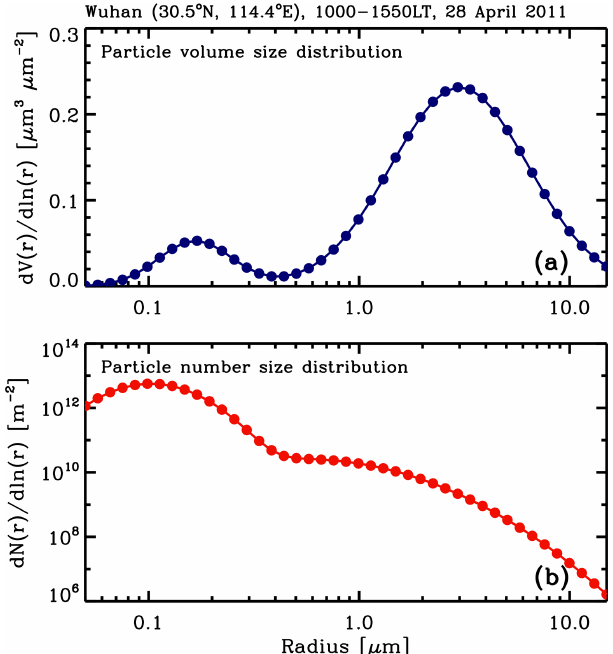
Figure 5. Column-integrated (a) particle volume size distribu- tion and (b) particle number size distribution derived from sun photometer observations at Wuhan (30.5 ◦ N, 114.4 ◦ E) during 10:00–15:50LT on 28 April 2011 based on GRASP-AOD algo- rithm. Ground-based polarization lidar observation verified that dust episodes occurred during this